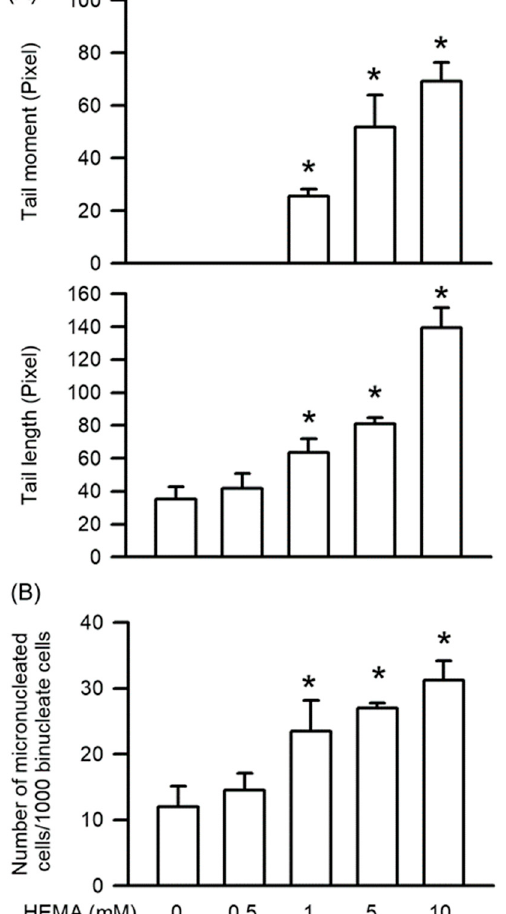
Figure 3. HEMA induced genotoxicity in RAW264.7 cells. ( A ) After the Comet assay, genotoxicity was quantified as tail moment and tail length. ( B ) After the MN assay, genotoxicity was quantified as MN formation. Data are expressed as mean ± SD. The number of parallel measurements is 4. * means that p < 0.05 compared with HEMA at the concentration of 0 mM.